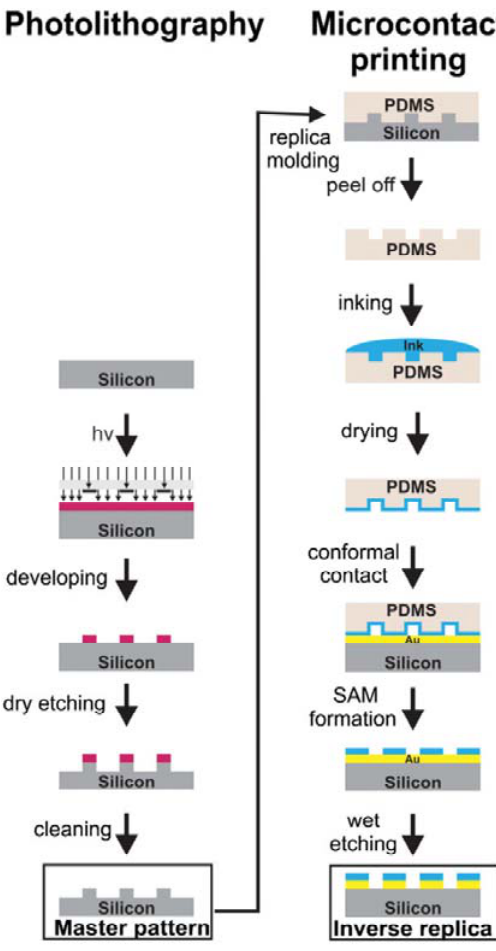
Figure 12. Schematic comparison of photolithography vs. microcontact printing ( μ CP).